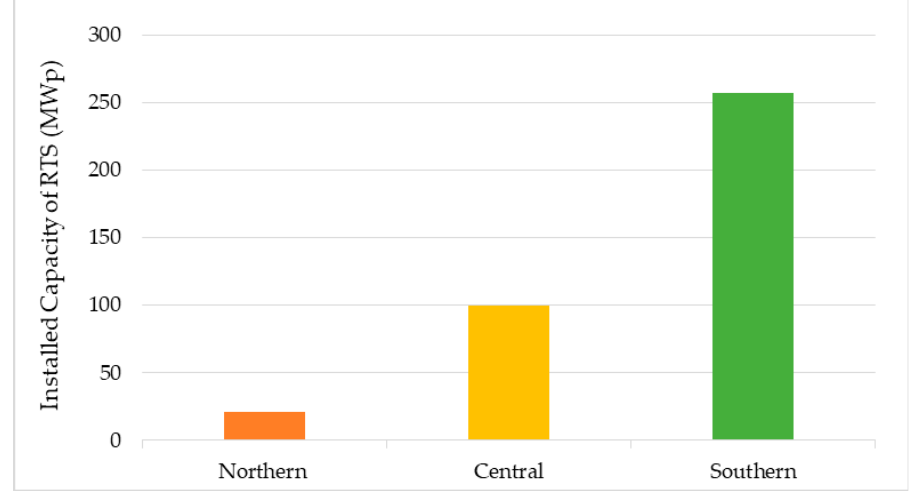
Figure 9. Total installed capacity of RTS in 2019.